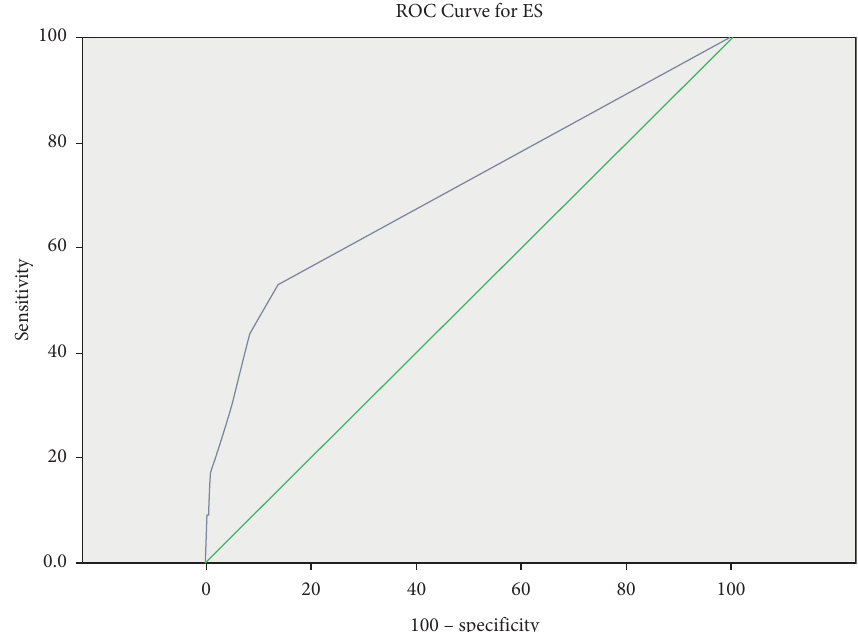
Figure 2: Receiver operating characteristic curve for erythrocyte suspension transfusion